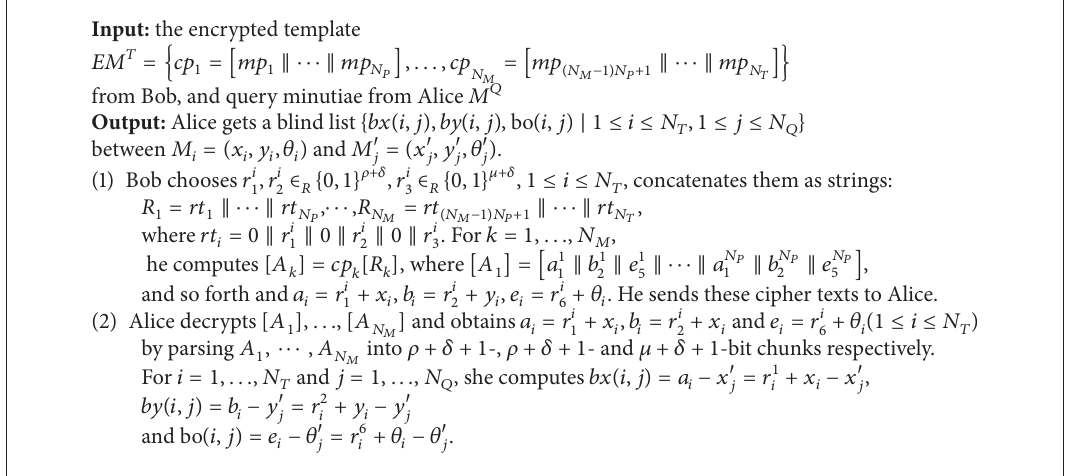
Algorithm 2: City-block-distance ( 𝐸𝑀 𝑇 , 𝑀 𝑄